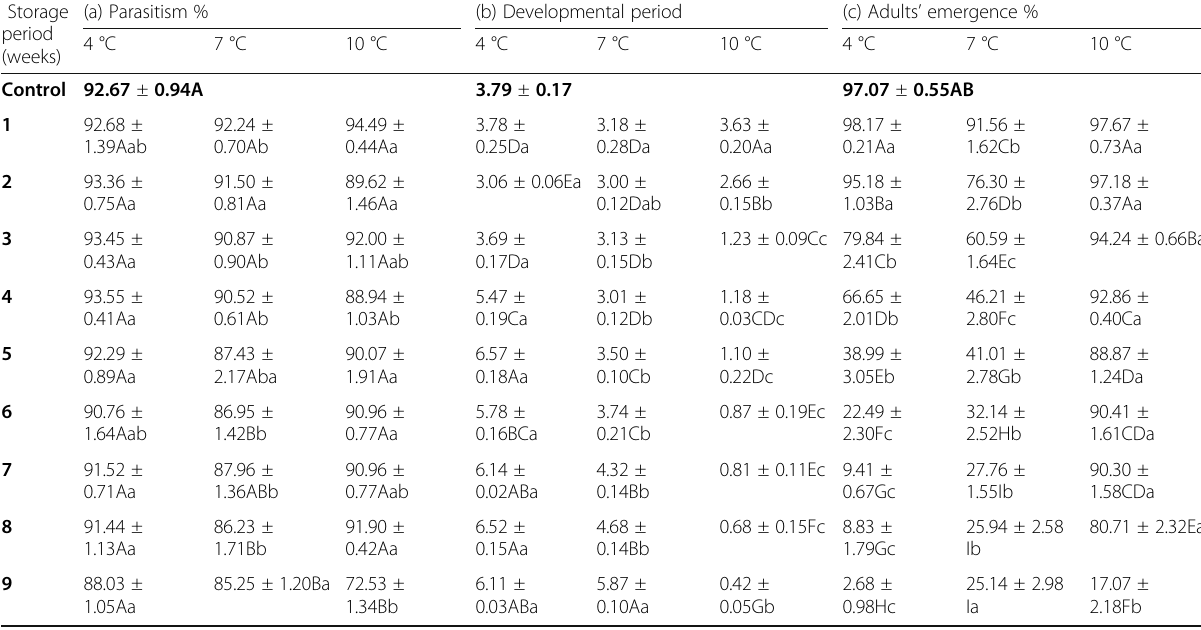
Table 8 Effect of cold storage on the parasitism%, developmental period and adults' emergence % of Trichogrammatoidea bactrae in parental generation during storage of parasitoid pupae at different low temperatures Storage